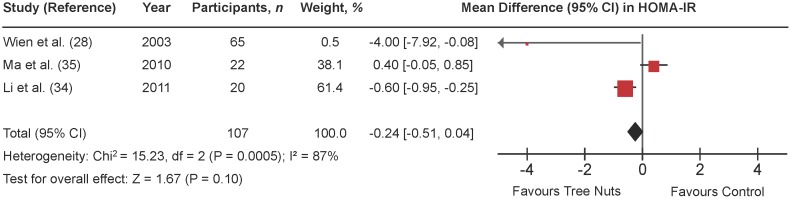
Forest plots of randomized controlled trials investigating the effect of diets supplemented with tree nuts on HOMA-IR in individuals with type 2 diabetes.Pooled effect estimate (diamond) for homeostasis model assessment of insulin resistance (HOMA-IR). Data are expressed as weighted mean differences (MD) with 95% CIs, using the generic inverse-variance fixed-effects model. Paired analyses were applied to all crossover trials. Inter-study heterogeneity was tested by the Cochran Q-statistic and quantified by I2 at a significance level of P<0.10. n = number of participants in each treatment group.